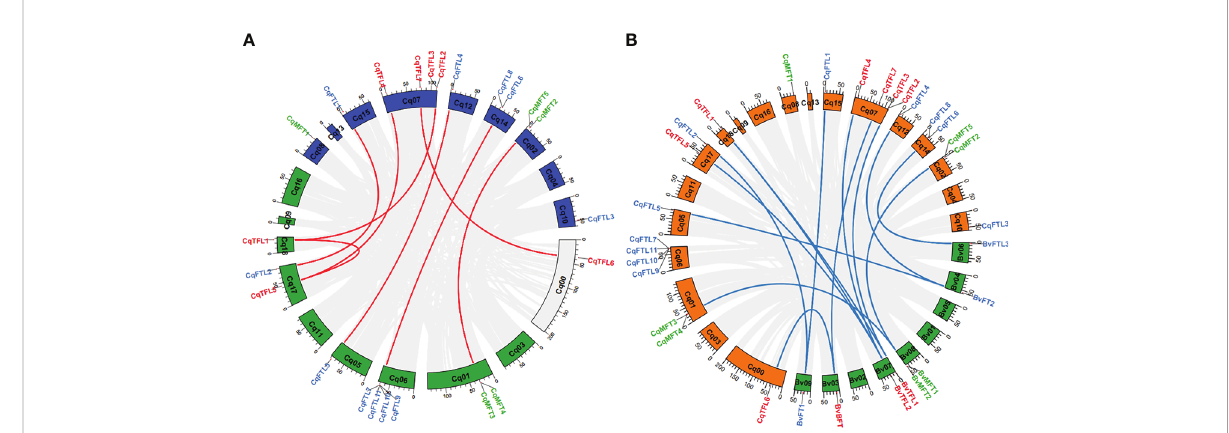
FIGURE 5 Circos plots shows the syntenic relationships between PEBP s from sub-genome A and B of quinoa and between PEBP s of quinoa and sugar beet. (A) Schematic representation of the syntenic relationships between homoeologous PEBP s of sub-genome A (blue) and B (green). Gray lines connect the homoeologous gene pairs of different chromosomes. Homoeologous PEBP s in quinoa are linked by red lines. (B) Syntenic relationships between the homoeologous PEBP s of quinoa and sugar beet. Chromosomes of quinoa and sugar beet are colored in green and orange, respectively. Gray lines connect the homoeologous gene pairs of quinoa and sugar beet. Blue lines connect the homoeologous PEBP gene pairs of quinoa and sugar